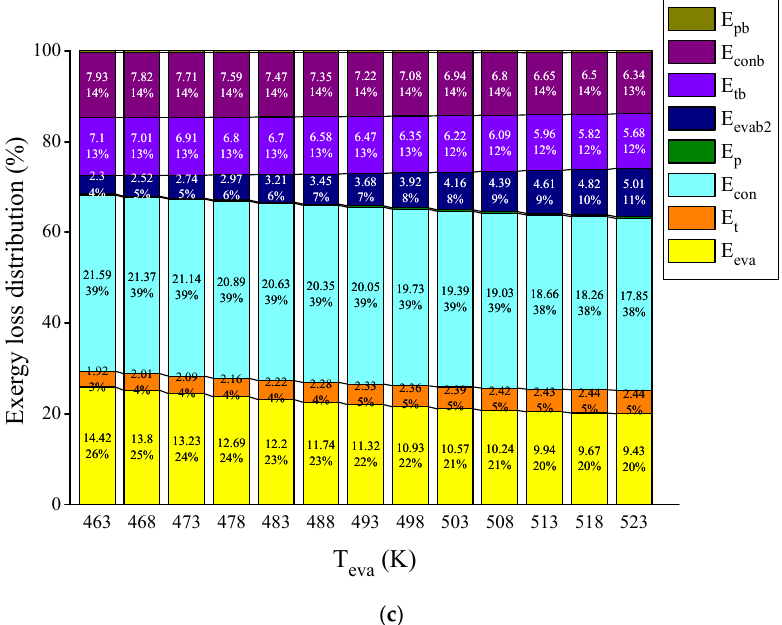
Figure 4. Variation of exergy loss distribution with HT loop evaporation temperature: ( a ) Hexane / toluene; ( b ) cyclopentane / toluene; ( c ) R123 / toluene.